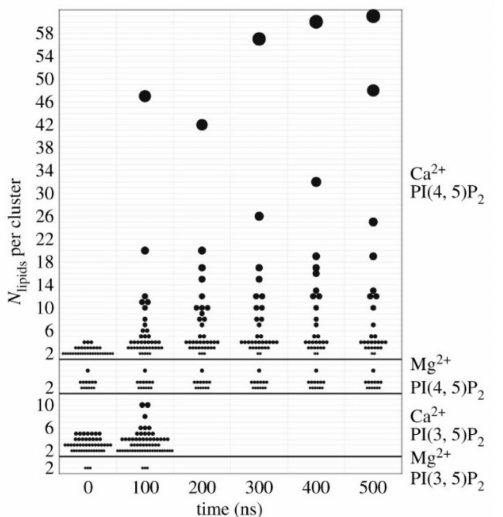
Figure 4. Histograms of cluster of lipids which is also measured on the vertical axis. Only the unique combination of PI(4, 5)P 2 and Ca 2 + shows large and growing clusters. The symbol area is proportional to the number of lipids in the cluster (Bradley et al.)